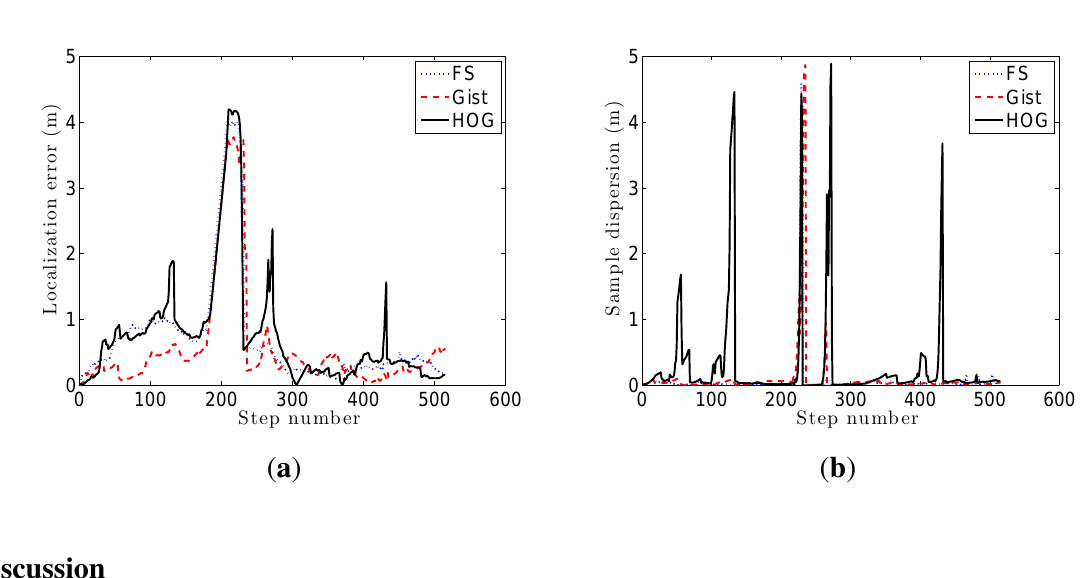
Evolution of the localization error and the sample dispersion in the previous